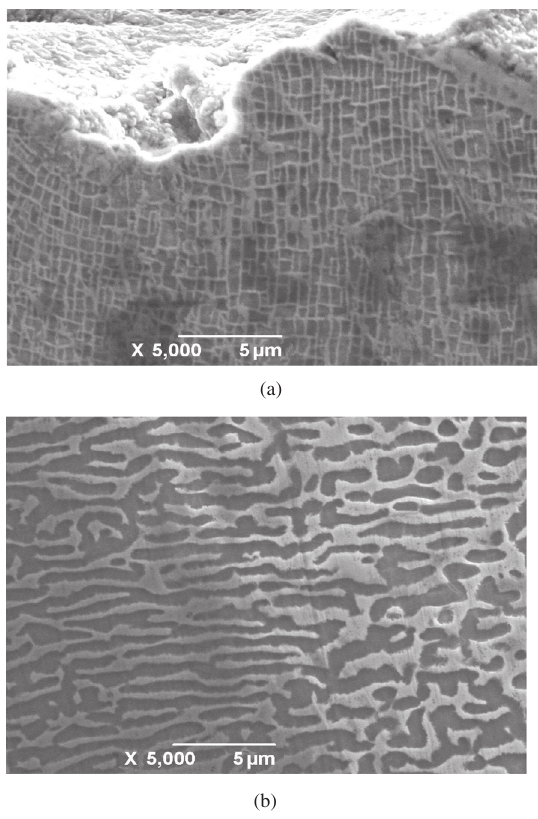
Figure 11: Microstructure of the fracture zones from a